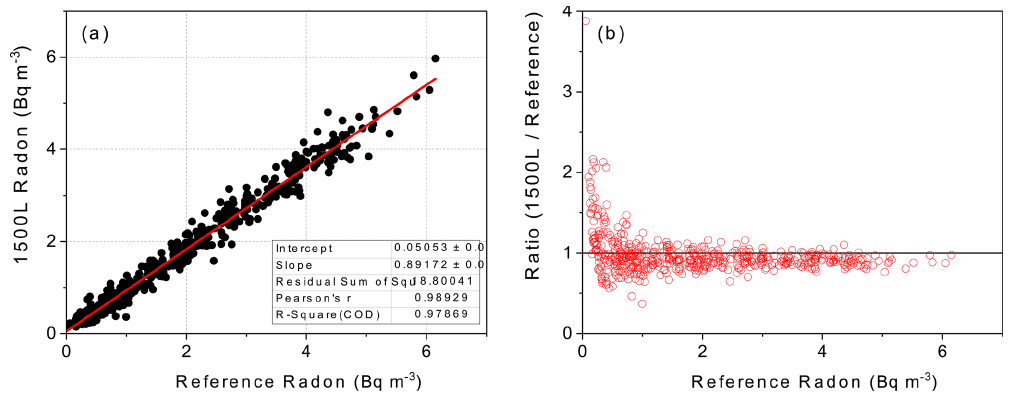
Figure 15. (a) regression of 1500L and reference monitor radon observations, and (b) dependence of the 1500 / 200L ratio on absolute radon concentration as measured by the reference